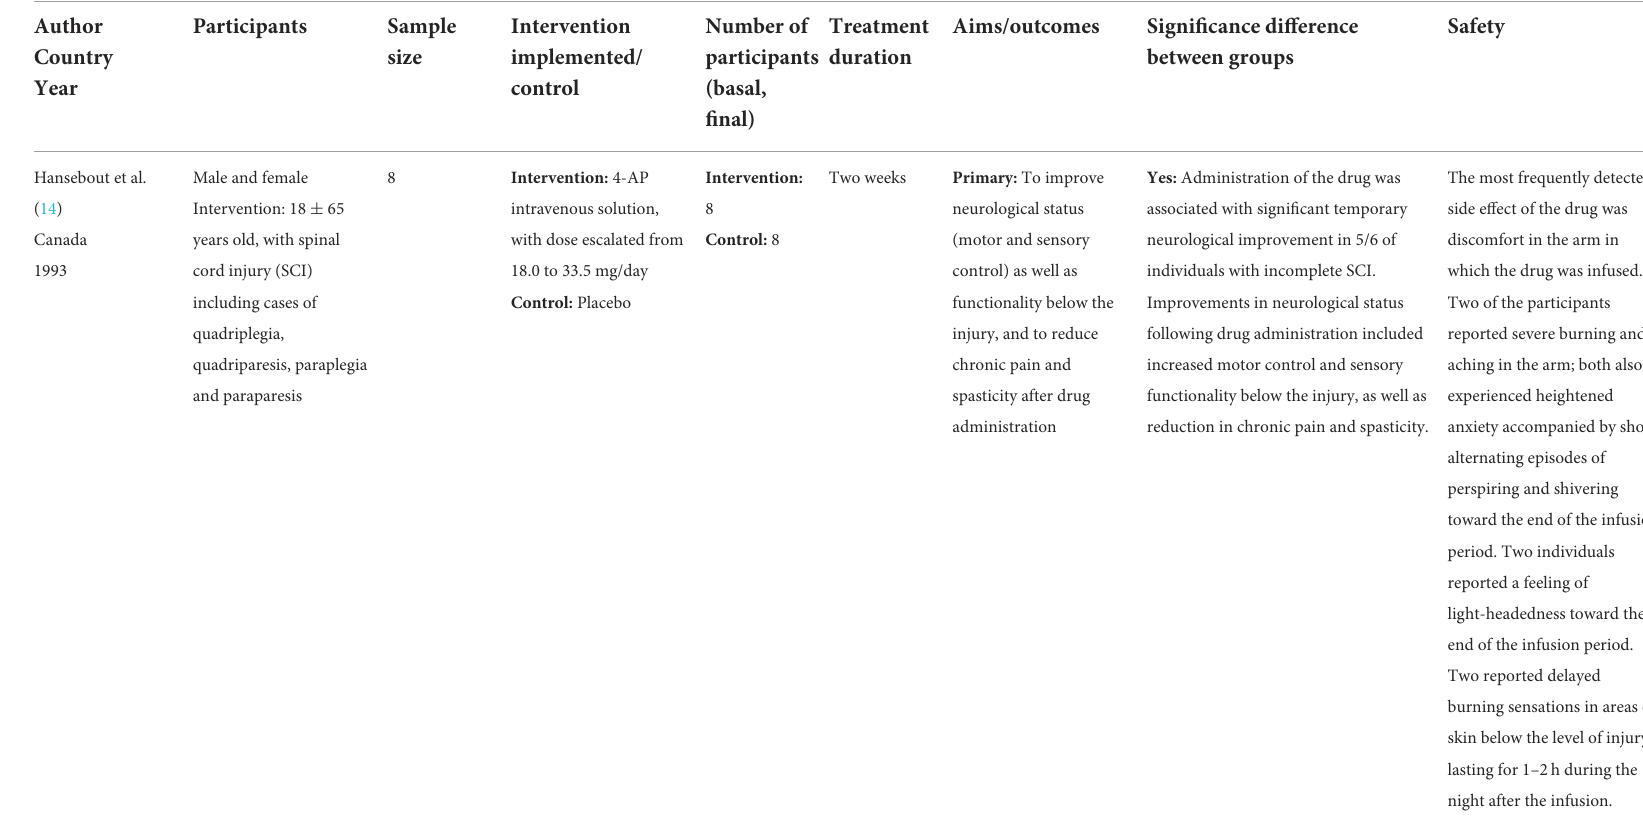
TABLE 2 Main characteristics of randomized control trials assessing the effects of 4-aminopyridine on the treatment of spinal cord injury. Efficacy of 4-aminopirydine